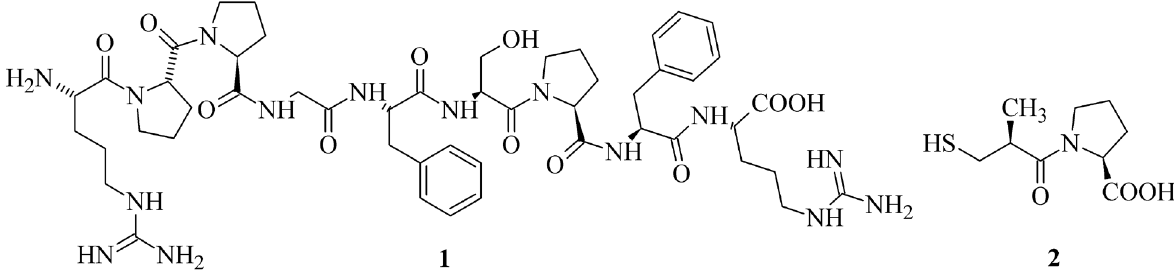
Figure 1 - Structure of bradykinin ( 1 ), a peptide extracted from Bothrops jararaca and the drug captopril ( 2 , Captoten ® ) an ACE inhibitor used for the treatment of hypertension designed from molecular simplification of 1 .